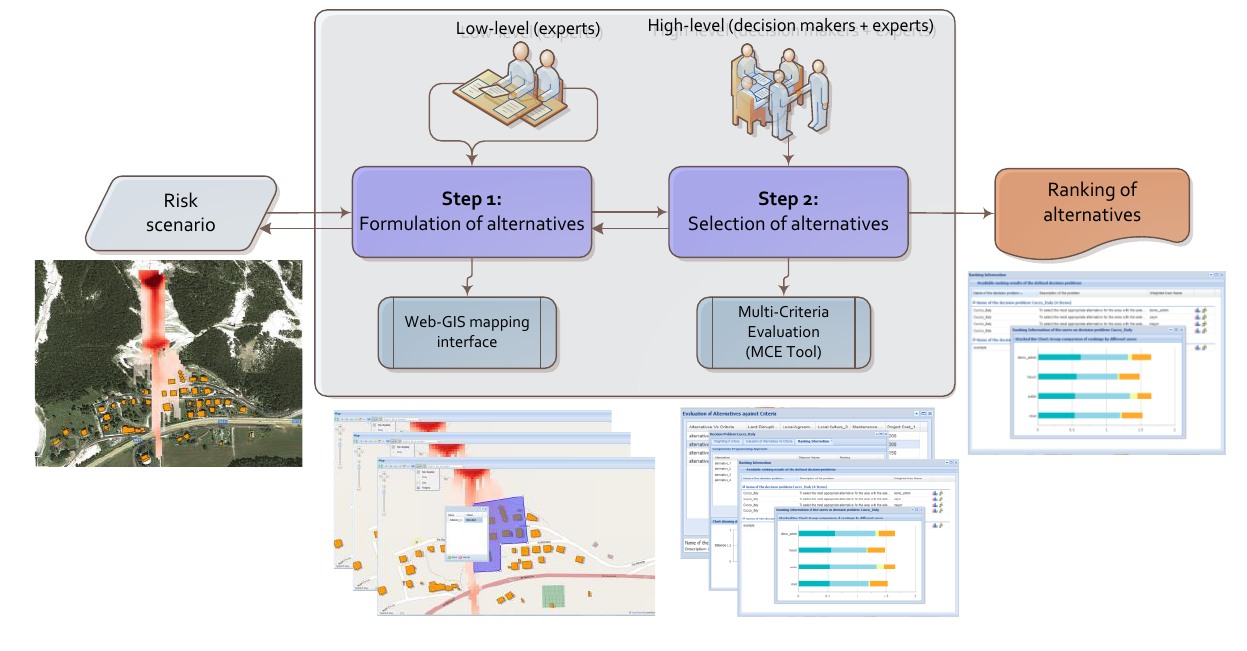
Figure 1. A two-stage workflow of the participative